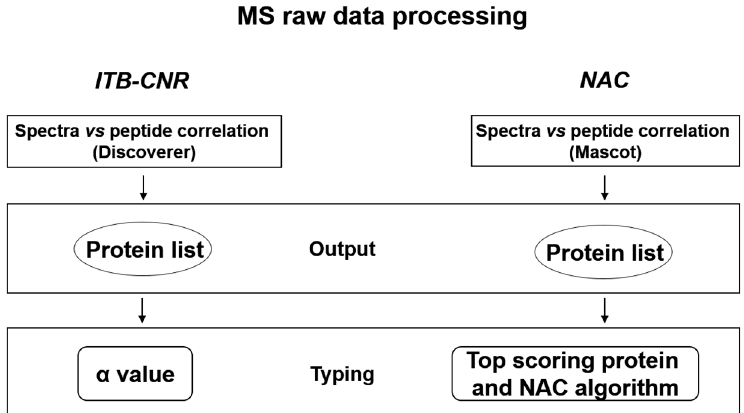
Figure 2. Scheme of proteomics data analysis at ITB-CNR and NAC facilities.